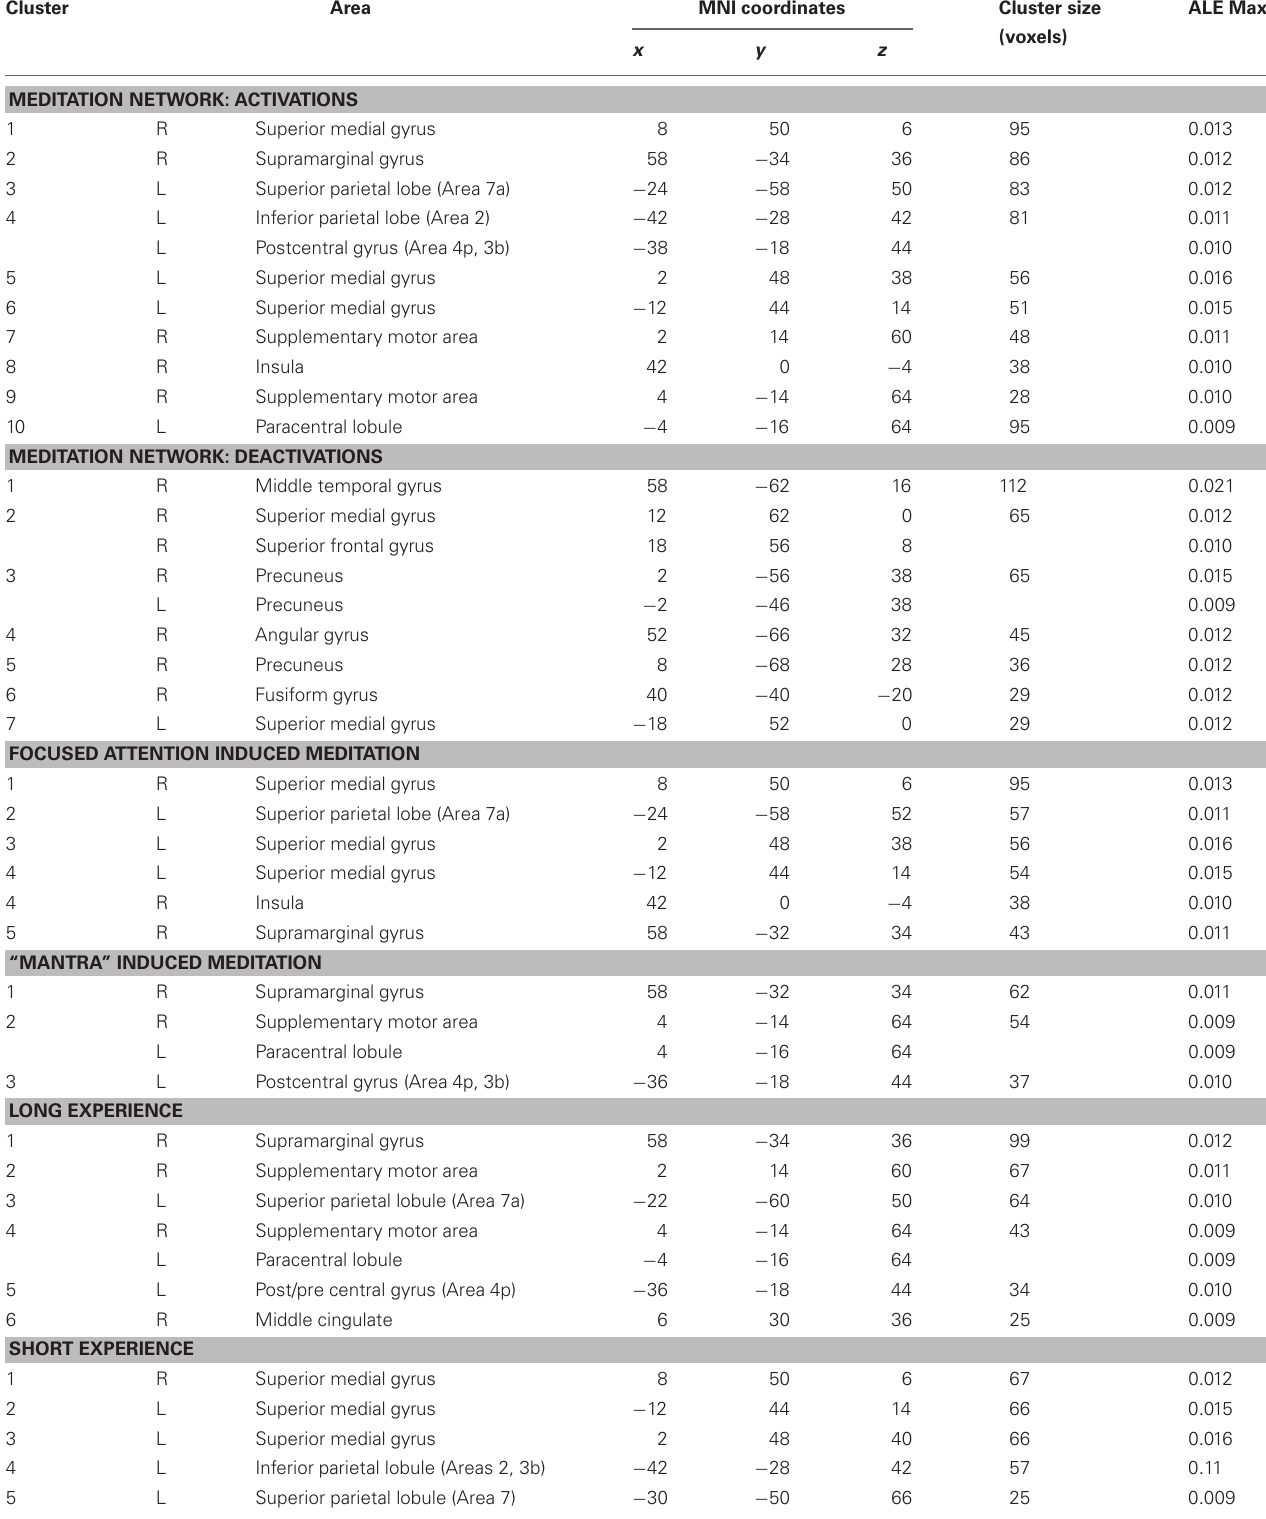
Table 2 | Results from the ALE meta-analysis.